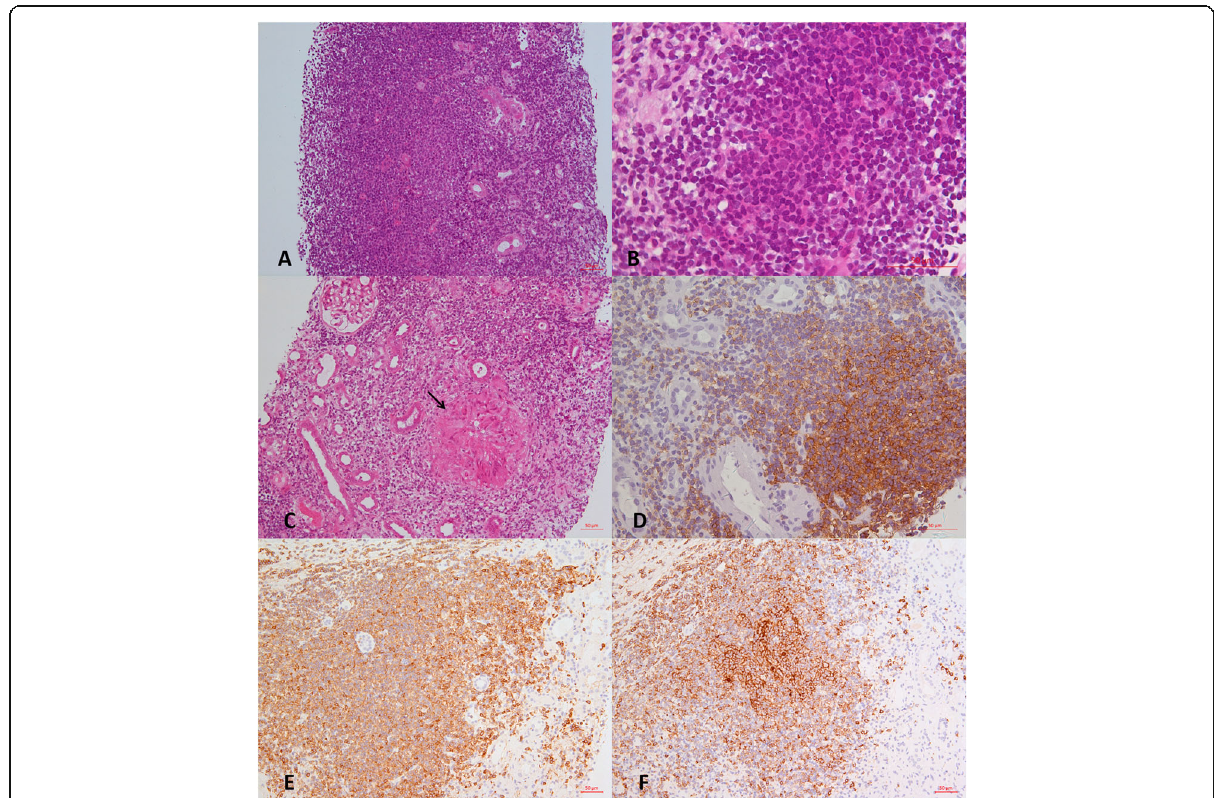
Fig. 1 Representative light microscopic findings of renal biopsy. A . CLL cells infiltration was seen in the renal interstitium (HE, ×200). B . Vaguely nodular pattern was seen in the renal interstitium(HE, × 630). C . Interstitial epithelioid granulomas were formed in the renal interstitium as indicated by the arrow (HE, × 200). D . Infiltrating CLL cells stain positively for CD20 (Immunohistochemistry, × 400). E . Infiltrating CLL cells stain positively for CD5 (Immunohistochemistry, × 200). F . Infiltrating CLL cells stain positively for CD23 (Immunohistochemistry, ×